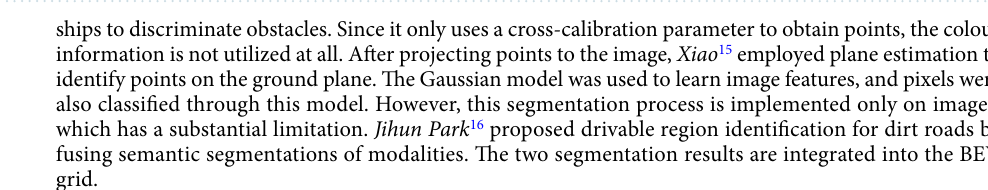
Figure 1. Method framework in this paper. The output of the image space can be seen as the terminal result for the